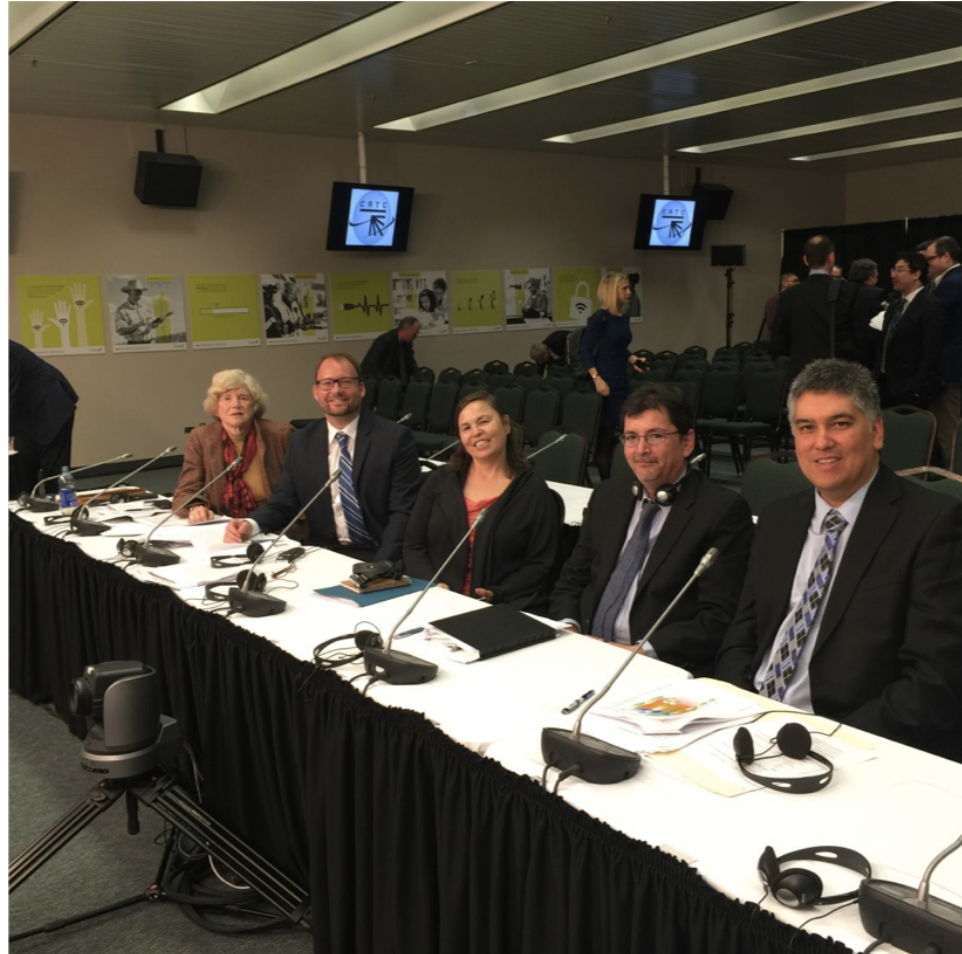
Figure 2: FMCC team at CRTC